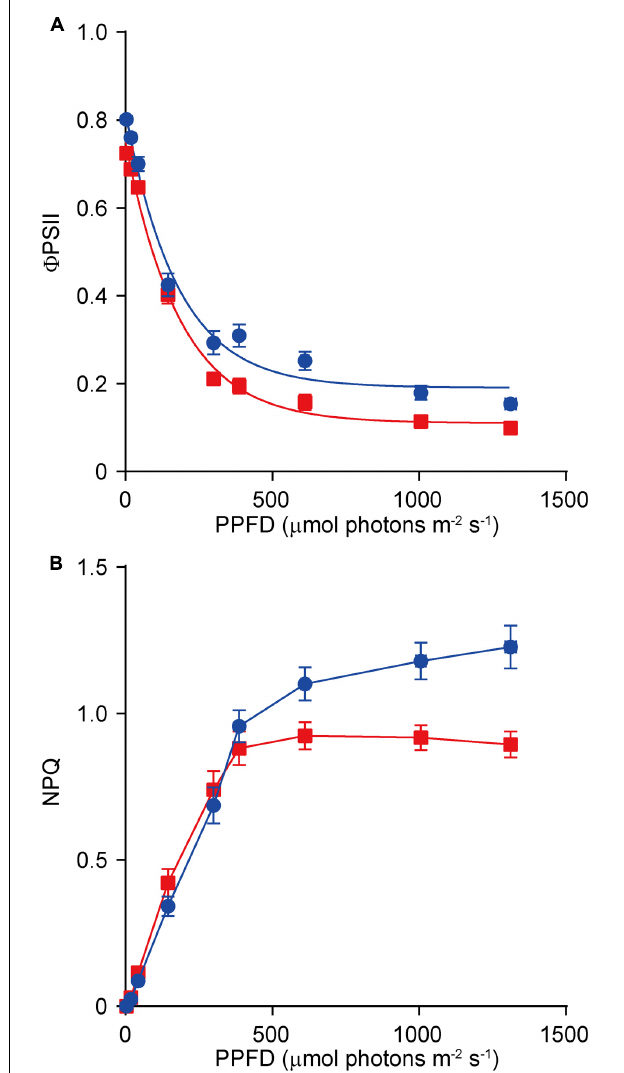
FIGURE 5 | Light-response curves of PSII quantum yield ( (cid:56) PSII) (A) and non-photochemical quenching (NPQ) (B) in the wild-type (WT, in blue) and the dy1 mutant (in red) seedlings. The measurements were taken at photosynthetic active photon flux densities (PPFD) of 3, 19, 43, 145, 300, 387, 611, 1,006, and 1,312 µ mol m − 2 s − 1 . Data represent means ± SD ( n = 6).